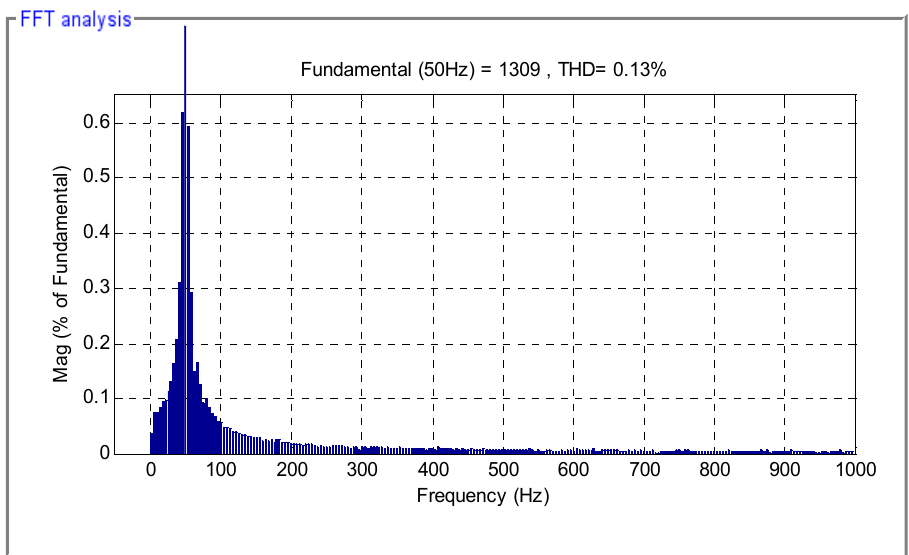
Figure 24. THD (DVC).